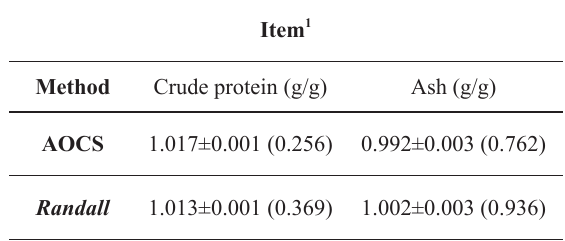
Total chlorophyll concentration in forages and cattle feces Average recoveries of crude protein and ash according to